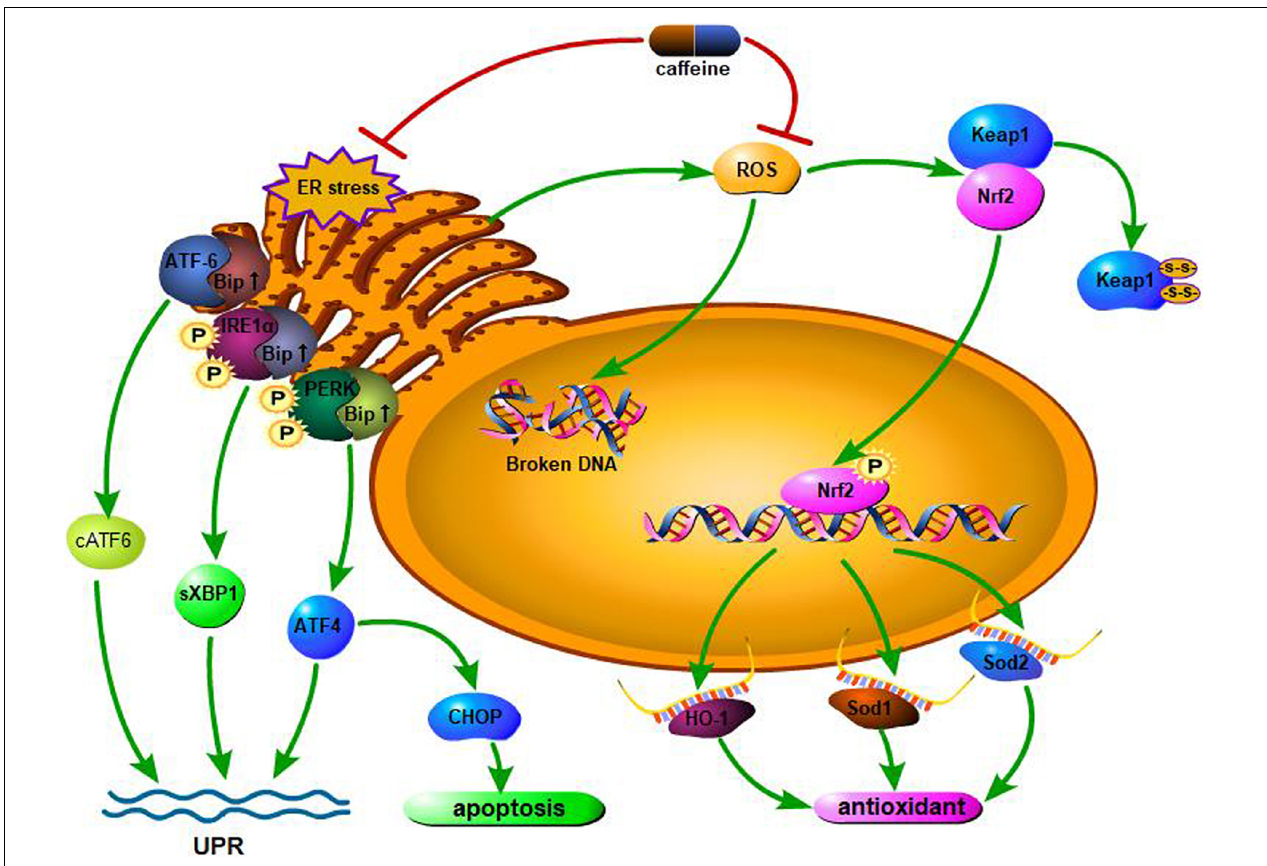
FIGURE 1 | Hyperoxia increases the levels of the endoplasmic reticulum (ER) stress marker Bip and downstream effectors. On sensing the presence of ER stress, both PERK and IRE1 α are phosphorylated, activating downstream effectors, while ATF-6 is cleaved. Through the above reactions, the body initiates the unfolded protein response (UPR), alleviating oxidative stress damage. If the stress persists, the UPR becomes ineffective. Cells will undergo CHOP-mediated apoptosis if the UPR fails to mitigate the ER stress. Caffeine can attenuate all of the responses. In addition, when excessive ROS are generated upon exposure to hyperoxia, caffeine administration can prevent and/or reduce hyperoxia-induced ROS generation and any resultant DNA damage. In response to oxidative stress, the expression of antioxidant genes is regulated by the Nrf2/Keap1 pathway. Expression of Nrf2, a cytoprotective mediator that regulates the expression of genes encoding antioxidant, anti-inflammatory, and detoxifying proteins is induced by hyperoxia, while expression of Keap1 is repressed. Caffeine inversely regulates RNA expression. The expression of Sod1, Sod2, and HO-1 are regulated by Nrf2. ROS, reactive oxygen species; IRE1 α , inositol-requiring enzyme 1 α ; cATF6, cleaved form of activating transcription factor 6; PERK, PKR-like ER kinase; Bip, binding immunoglobulin protein; sXBP1, spliced X-box binding protein 1; CHOP, CCAAT/enhancer binding protein homologous protein; ATF4, activating transcription factor 4; Nrf2, NFE2-related factor 2; Keap1, Kelch-like ECH-associated protein 1; HO-1, heme oxygenase-1; Sod1, superoxide dismutase 1; Sod2, superoxide dismutase